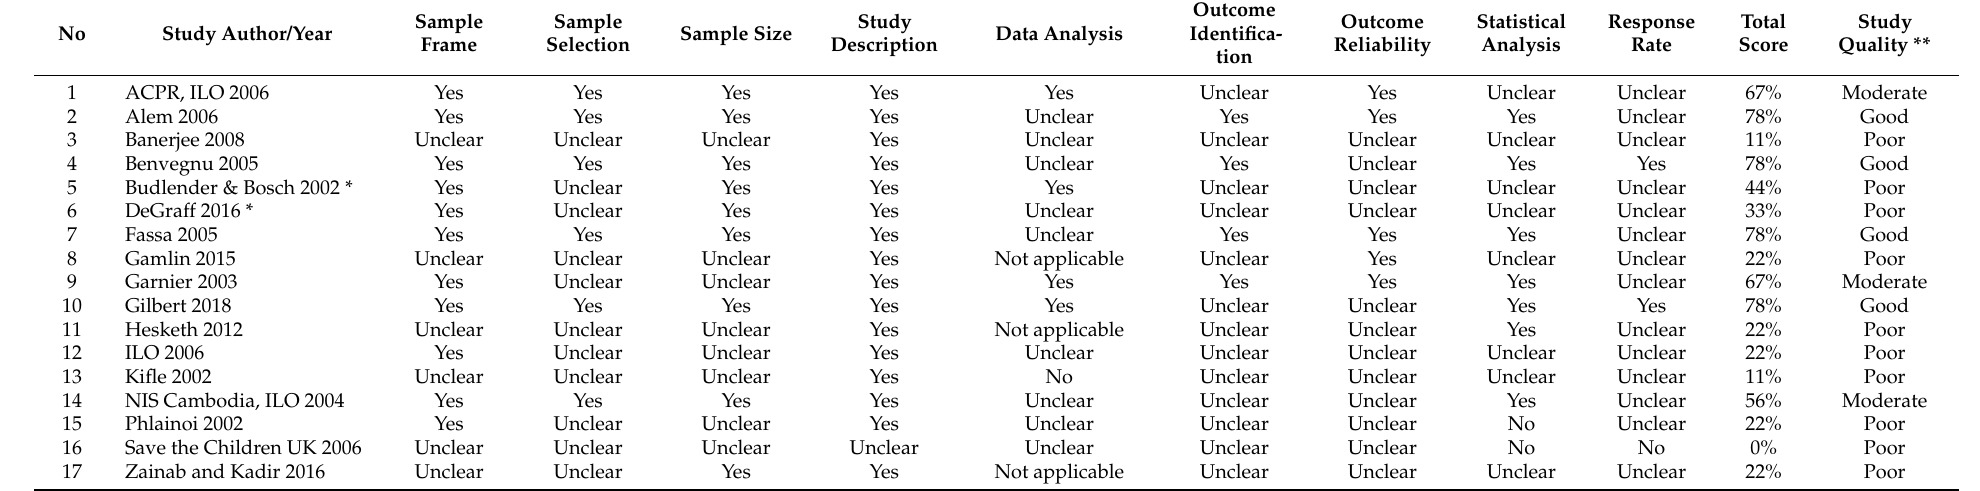
Table A1. Critical appraisal of cross-sectional child domestic worker health and violence studies ( n = 17).